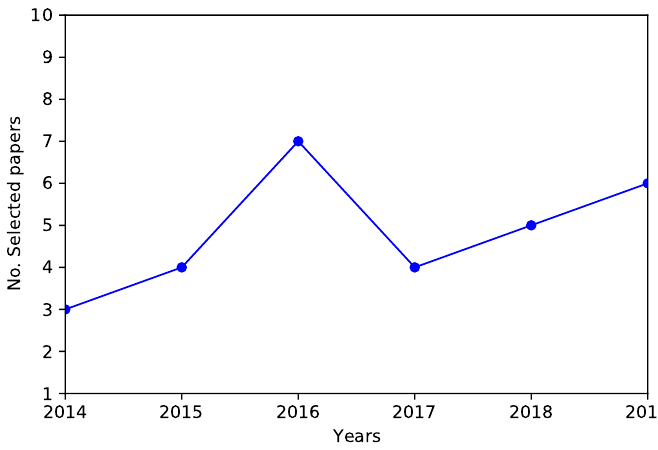
Figure 2. Selected papers by